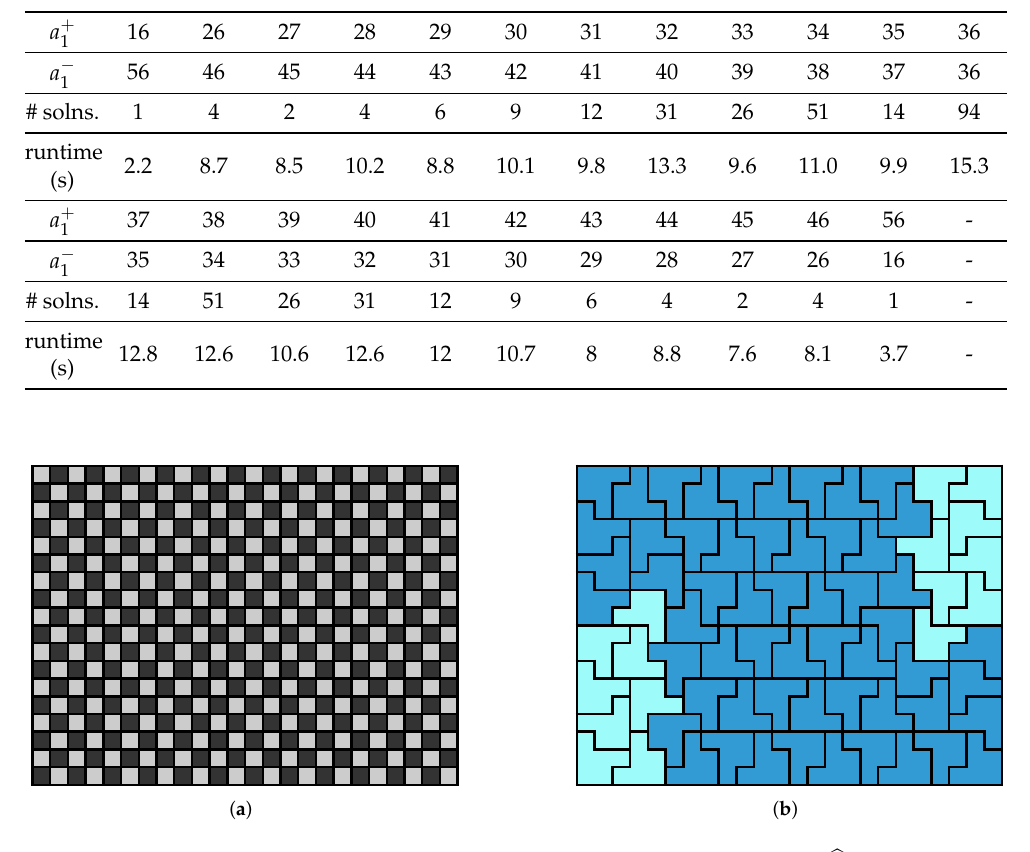
Figure 14. Target region and a tiling solution for Example 2: ( a ) the target region (cid:98) R , a checkerboard coloured 18 × 24 rectangle; ( b ) successful tiling of the target region (cid:98) R using 72 copies of a hexomino. The P + variants are coloured light-blue and the P − 1 optimal solution of the subproblem with ( a +